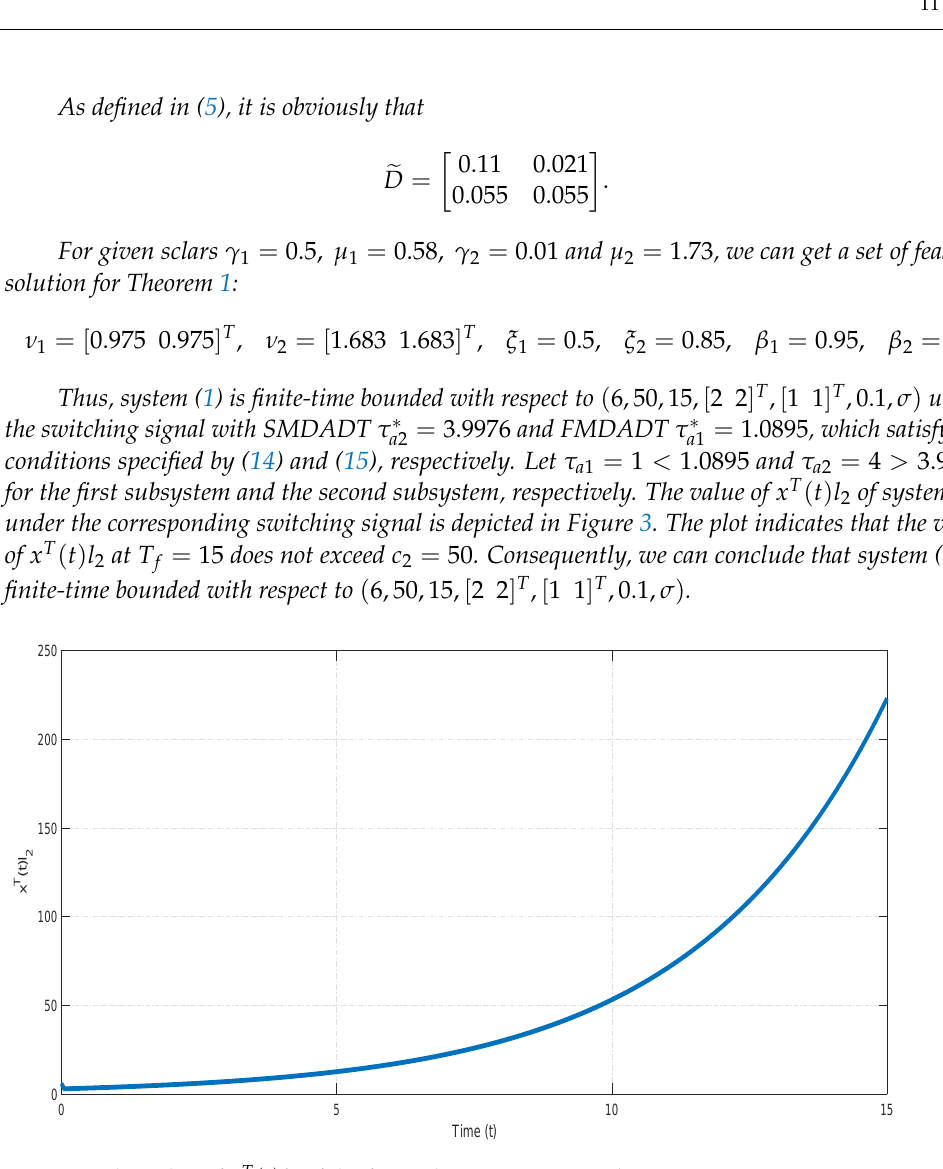
Figure 1. The value of x T ( t ) l 2 of the first subsystem in Example 1.